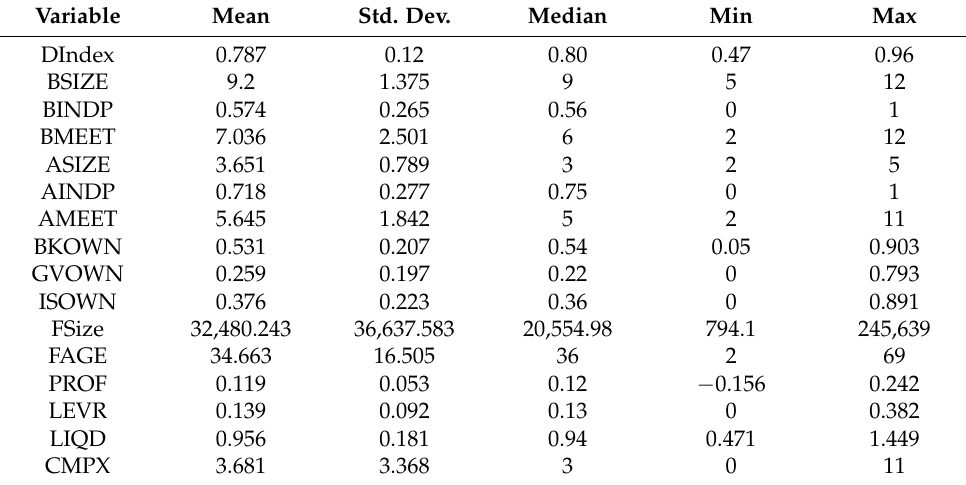
Table 3. Descriptive